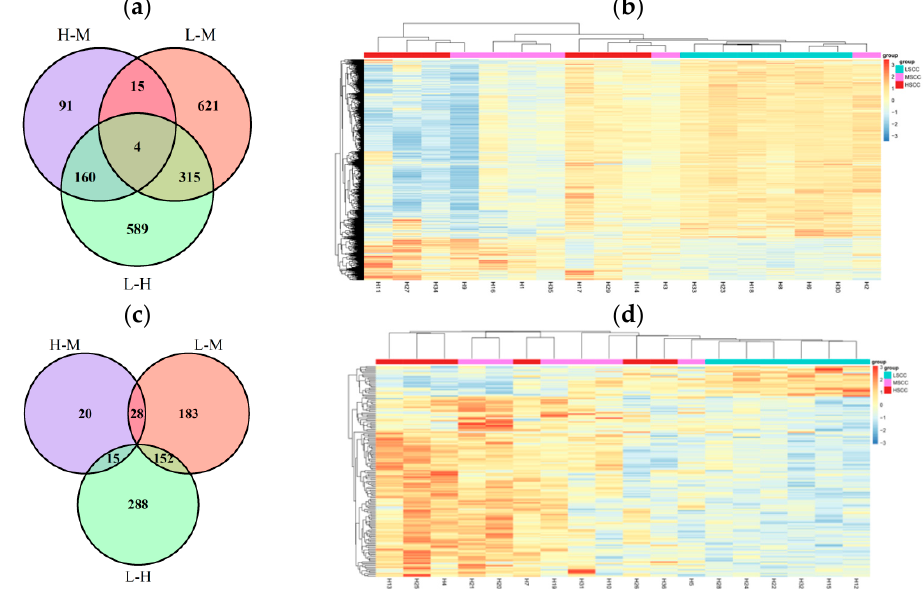
Figure 6. Differentially expressed genes identification. ( a , c ): Venn diagram showing the number of differentially expressed genes (DEGs) identified in each comparison in each site. ( b , d ): Heatmap showing the expression profile of top DEGs (FDR < 0.05). Left panel: site1, Right panel: site2. H − M: HSCC vs. MSCC, L − M: LSCC vs. MSCC, L − H: LSCC vs. HSCC.